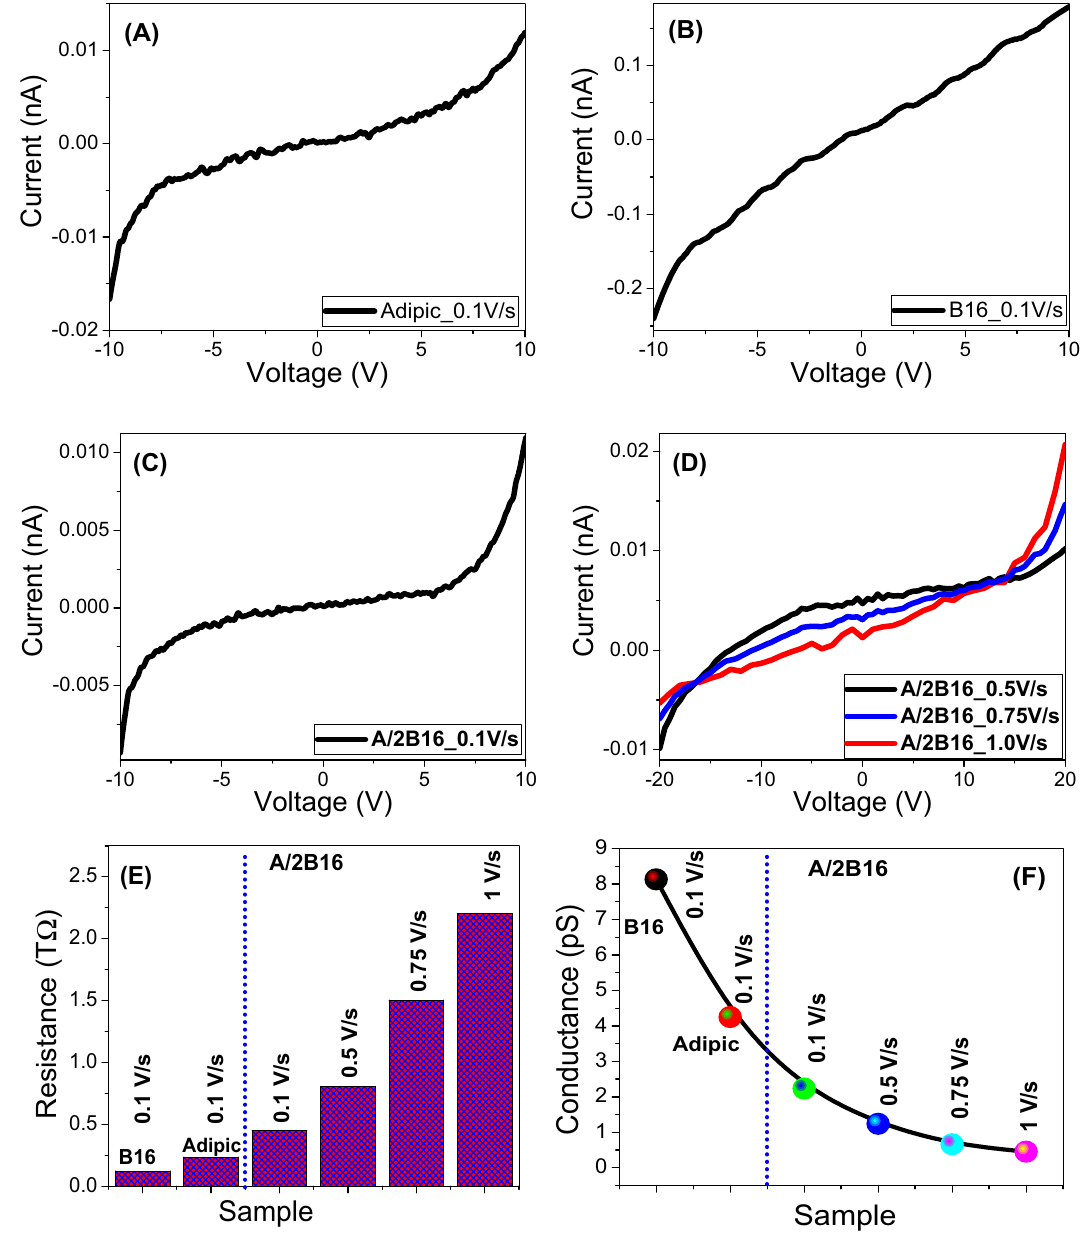
Figure 11. Current–voltage characteristics of ( A ) Adipic acid, A ; ( B ) Azopyridine, B16 and ( C ) their supramolecular H-bonded complex A/2B16 ; ( D ) current–voltage characteristics of A/2B16 at different scan rate; the obtained values of ( E ) resistance and ( F ) conductance of A, B16 , and A/2B16 at different scan